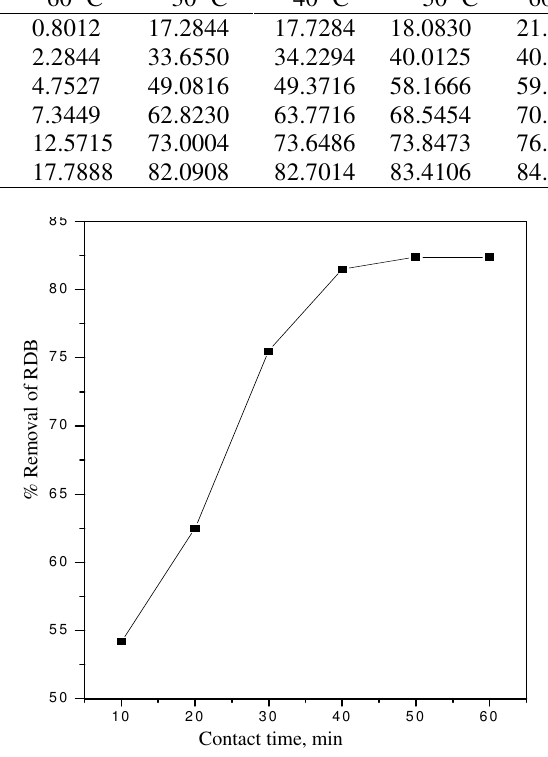
Figure 2 . Effect of contact time on the removal of RDB by